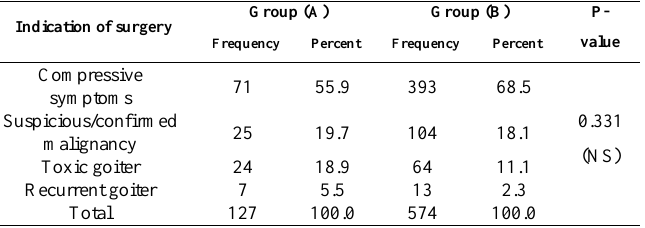
Table 2 : Table 2. Distribution of indications of surgery Indication of surgery